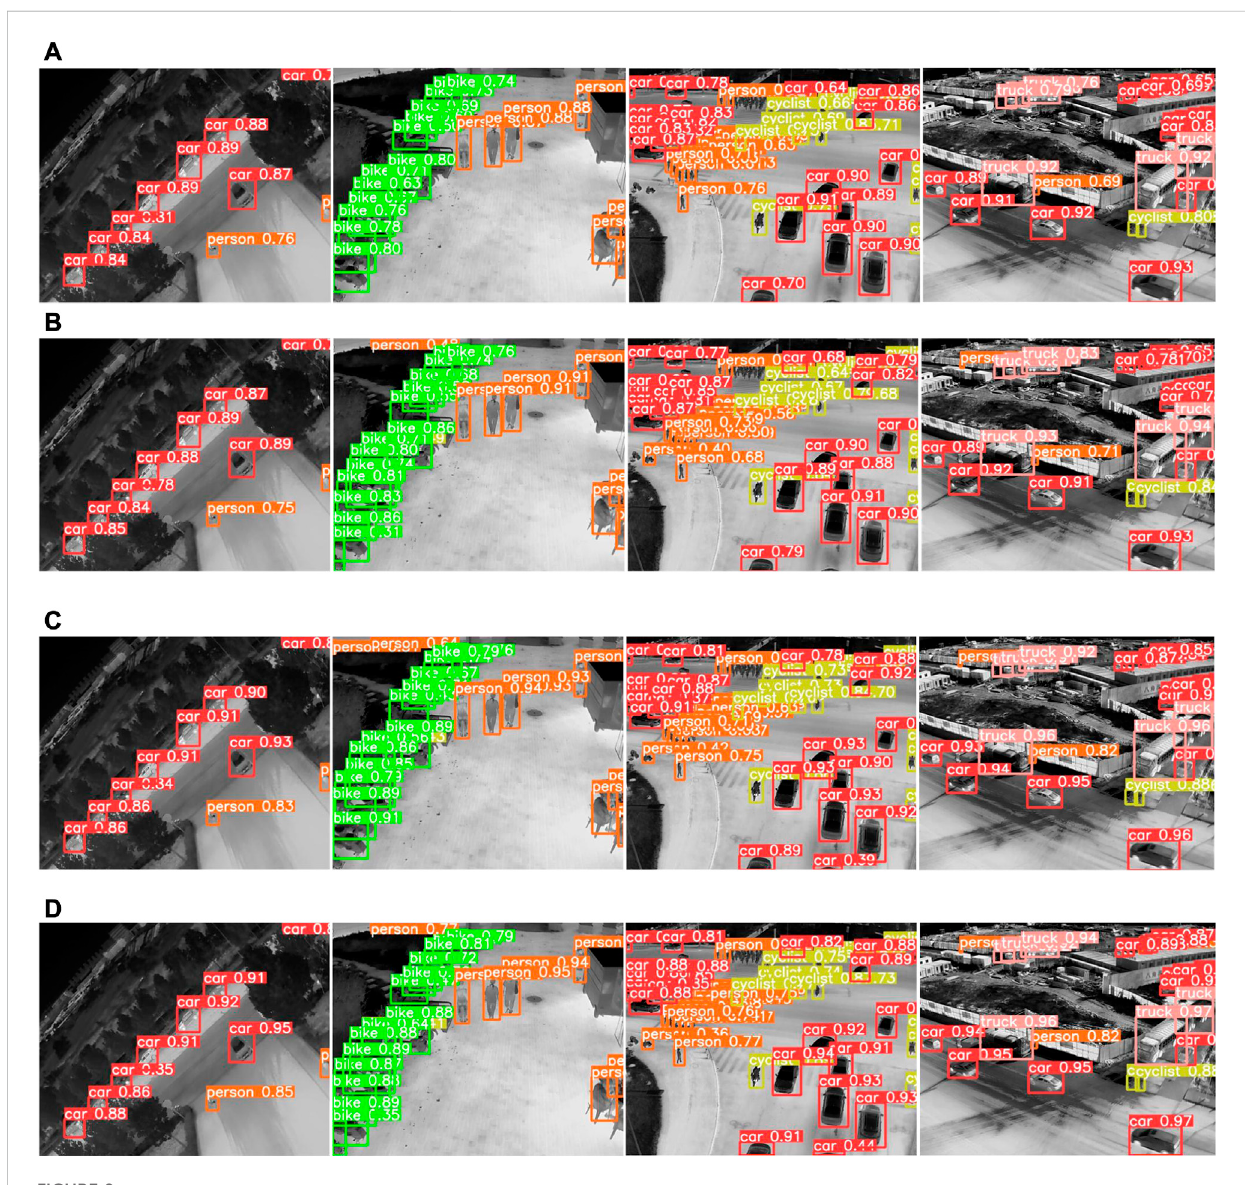
FIGURE 9 The results of various methods. (A) YOLOv5s (B) YOLOv5s + Ghost (C) YOLOv5s+Ghost +GCA (D)